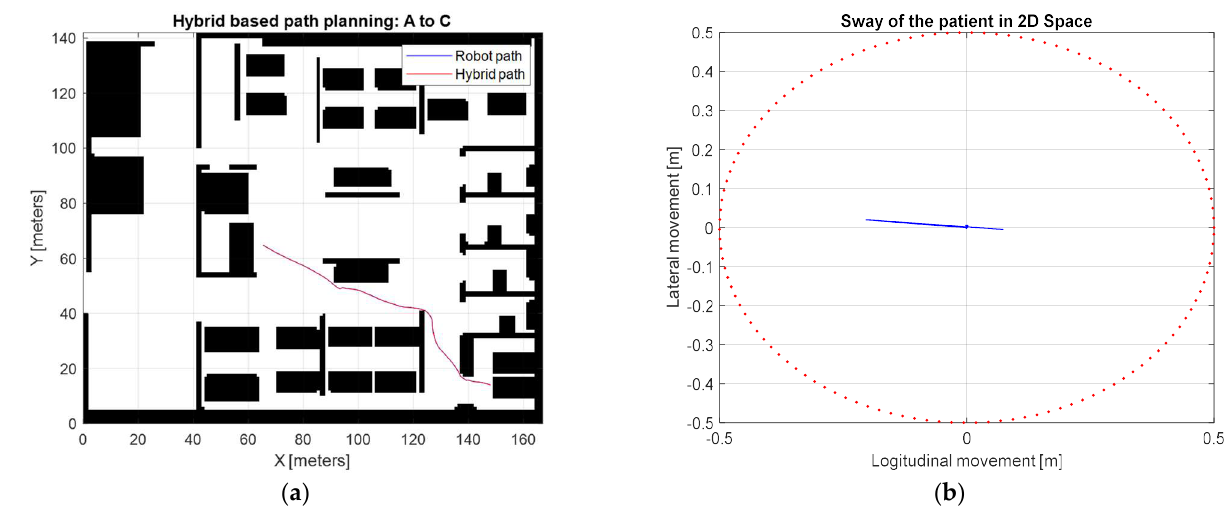
Figure 21. Motion control performance. ( a ) Reference path tracking performance. ( b ) Sway reduction performance in 2D space.